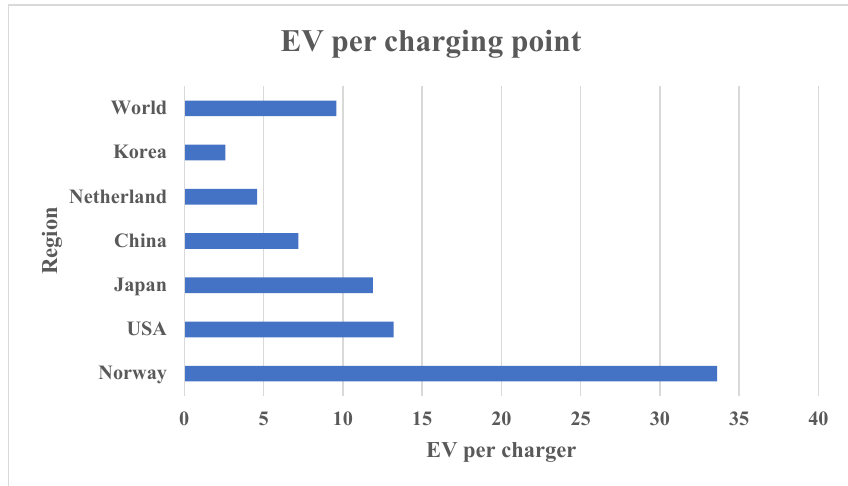
Figure 6. Global distribution of EV per charging point for 2021 [40].